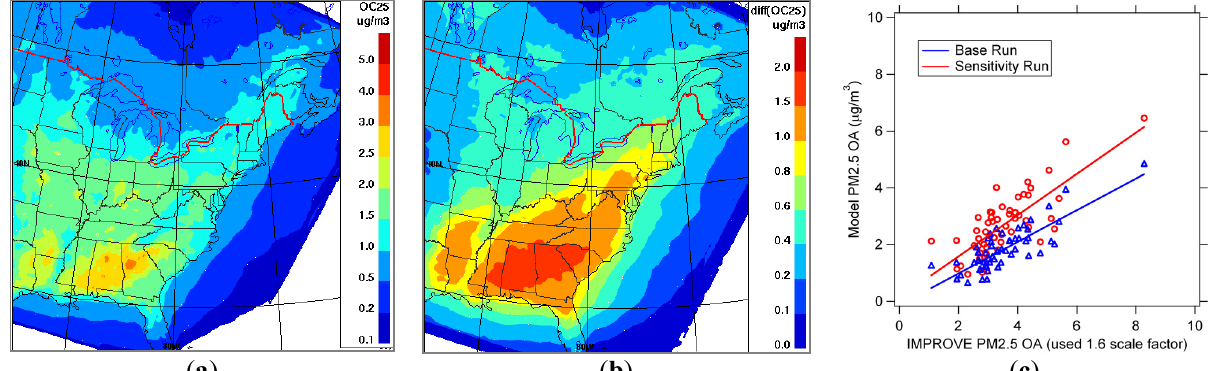
secondary organic aerosol (SOA): ( a ) base case averaged over Figure 4. Modeled PM 2.5 the 2-month simulation period; ( b ). difference in the modeled 2-month average PM SOA (“sensitivity”–“base case”); ( c ) model-observation comparison at the IMPROVE network